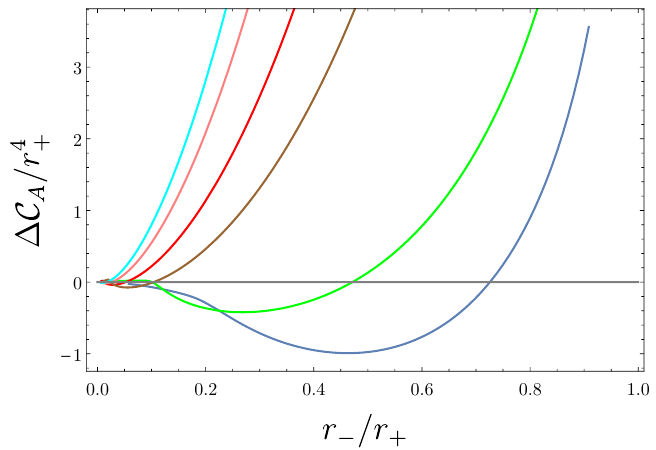
Figure 6. A plot showing the complexity of formation in the action formalism for different values of r + /‘ and for D = 5 . The curves correspond to r + /‘ = 5 , 10 , 50 , 100 , 200 , 300 in order from bottom to top in a vertical slice on the right side of the plot. Here we have set ‘ ct = ‘